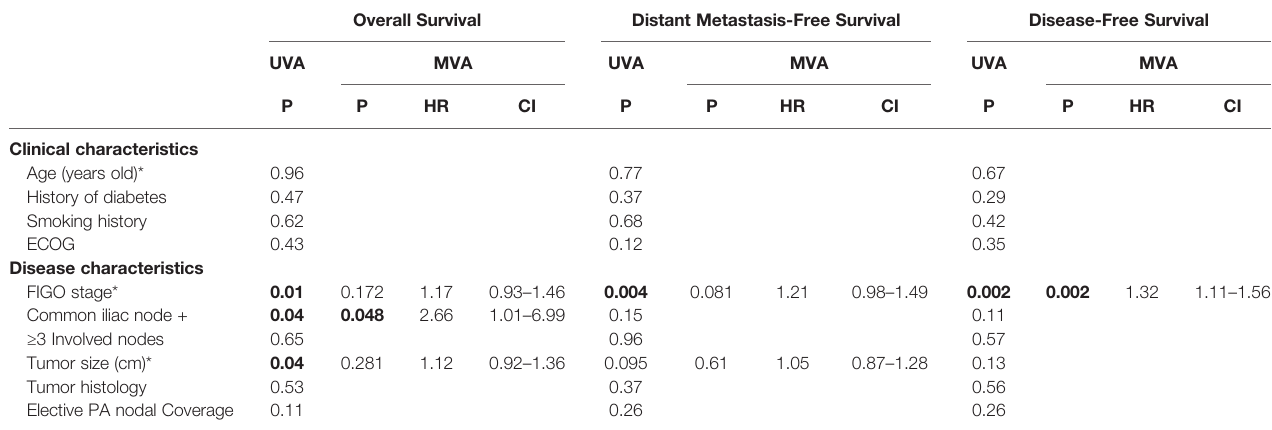
TABLE 2 | Analysis of factors associated with overall survival, distant metastasis free survival, and disease-free survival for 96 patients with node-positive cervical cancer treated with de fi nitive intent radiation. Overall Survival Distant Metastasis-Free Survival Disease-Free Survival